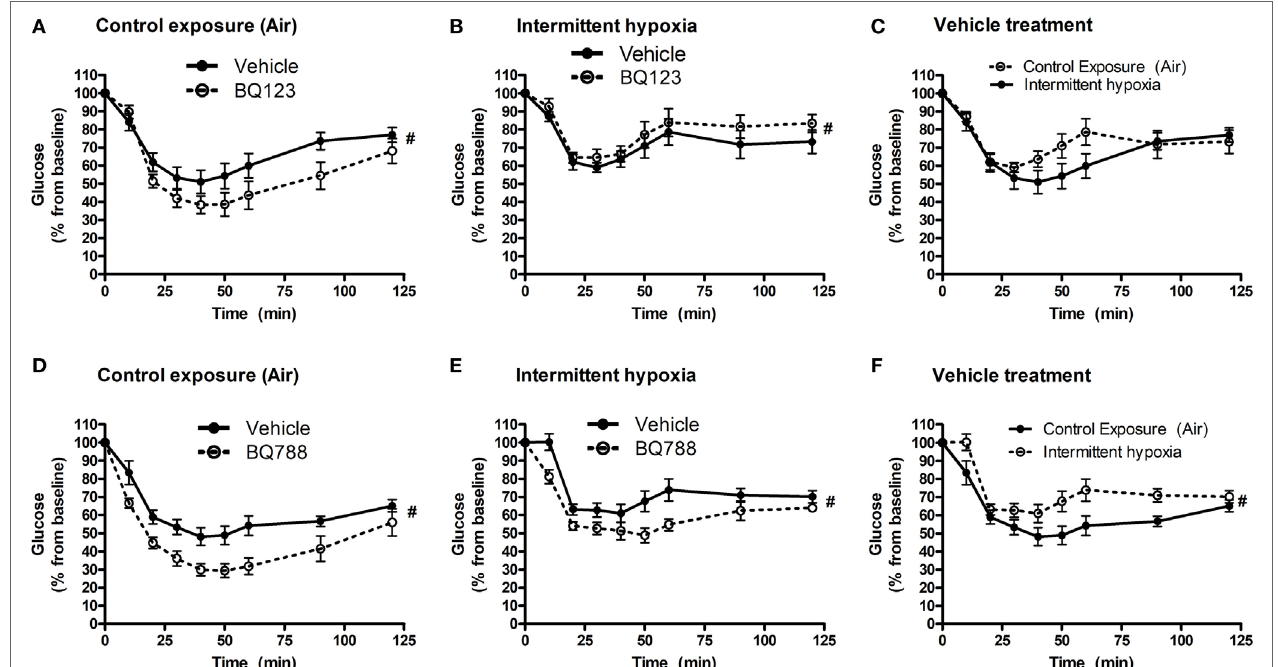
FigUre 3 | Intraperitoneal insulin tolerance tests (ITTs) in BQ-123 (a,B) and BQ-788 (D,e) and vehicle (c,F) treated groups. Data were analyzed using repeated measures ANOVA analysis of the glucose tolerance test (GTT) profiles investigating interaction between exposure groups (drug-treated versus vehicle-treated) and time of GTT. Upper panels: BQ-123- and saline (vehicle)-treated groups. Lower panels: BQ-788- and propylene glycol (vehicle)-treated groups # indicates p < 0.05 for differences between drug-treated versus vehicle-treated groups. N = 10 for each group.